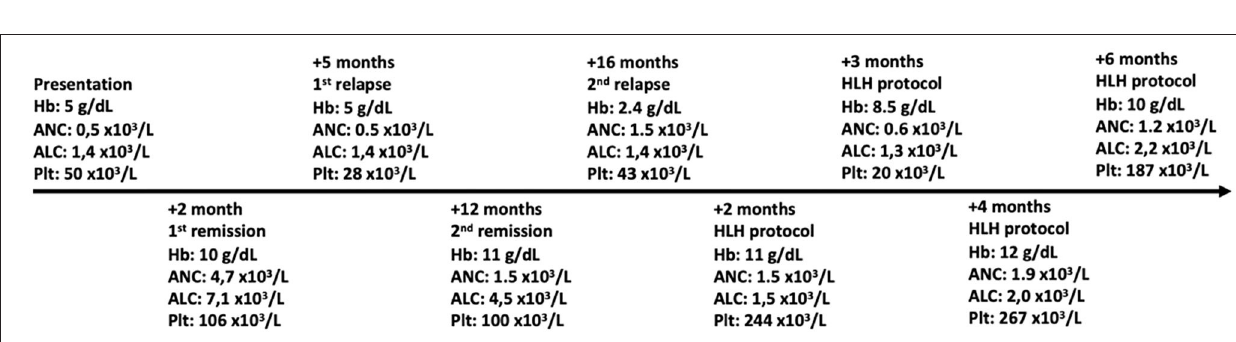
FIGURE 1 | (A) Pathogenic variant and a variant of uncertain significance (VUS) for the STXBP2 gene from ClinVar. The pathogenic variant c.1247-1G > C found in the patient is in a splicing site and therefore is not illustrated in this figure (variation ID: 330555; dbSNP: rs140148806). The VUS found in the patient is indicated by a black arrow (c.704 > A; p. Arg235gln). There are 10 pathogenic variants and 81 VUS described for STXBP2 in ClinVar, as shown in the figure. The color legend is indicated in the corner of the figure . (B) Protein alignment for the residue Arg235 (VUS) among five organisms: Homo sapiens , Rattus norvegicus , Mus musculus , Canis lupus familiaris , and Bos taurus . Conservation of the arginine (R) is highlighted in blue . Alignment position among the five species: 257; sequence position: 235.